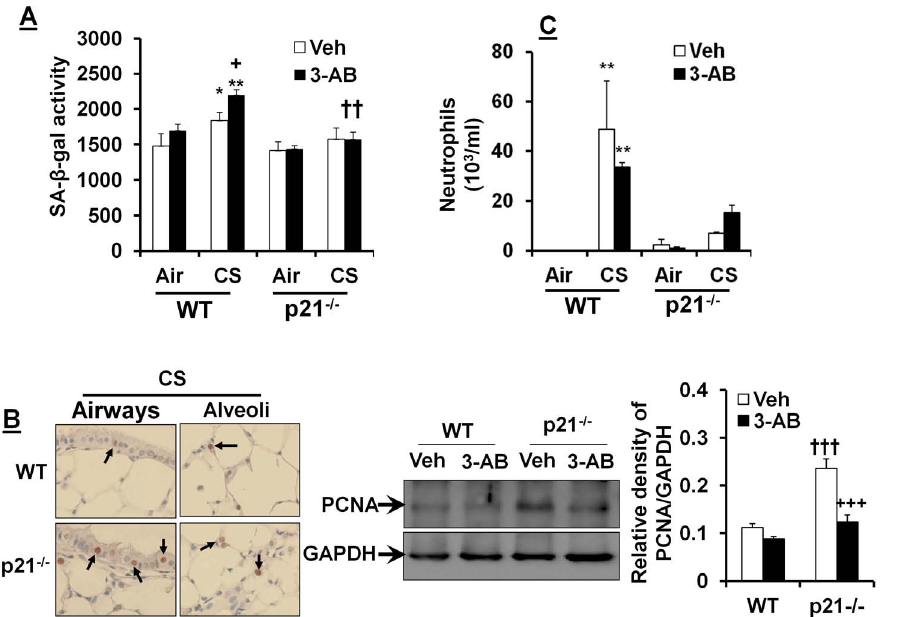
Figure 4. 3-AB increases CS-induced cellular senescence, but does not affect neutrophil influx in mouse lungs. 3-AB augmented CS- induced increase in SA- b -gal activity in WT, but not p21 -/- mice ( A ). p21 deletion increased the expression of PCNA in lungs as compared to WT mice exposed to CS, which was reduced by 3-AB treatment ( B ). p21 deletion attenuated CS-induced neutrophil influx in BAL fluid, which was not affected by 3-AB ( C ). Original magnification, 6 200. Gel pictures shown are representative of at least 3 separate mice. Relative density ratio is indicative of results after normalizing to corresponding GAPDH. Data are shown as mean 6 SEM (n=3-4 per group). * P , 0.05, ** P , 0.01 vs air group; + P , 0.05, +++ P , 0.001 vs Veh group; {{ P , 0.01, {{{ P , 0.001 vs WT mice.